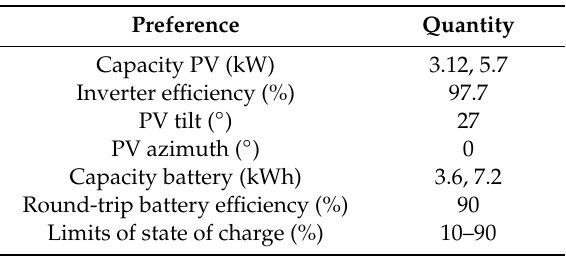
Table 2. Specifications of the PV system and battery storage.